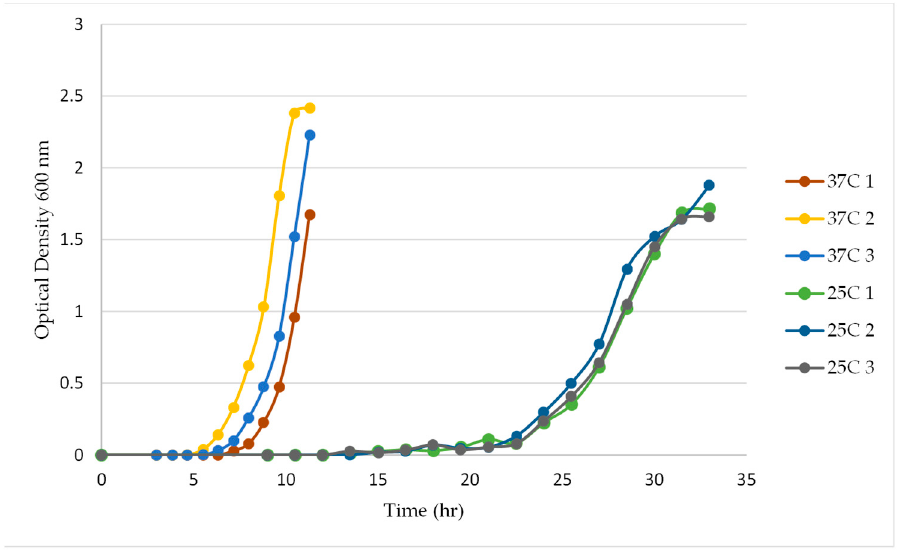
Figure 3. Growth of E. coli O157:H7 C7927 Φ V10 nluc lysogen at 37 °C and 25 °C.